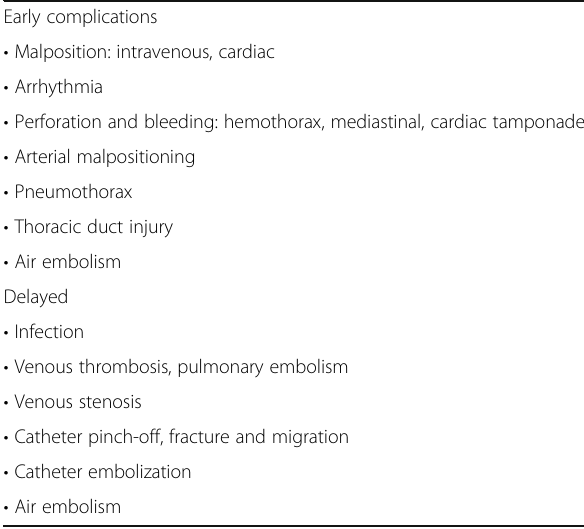
Table 1 Complications after port